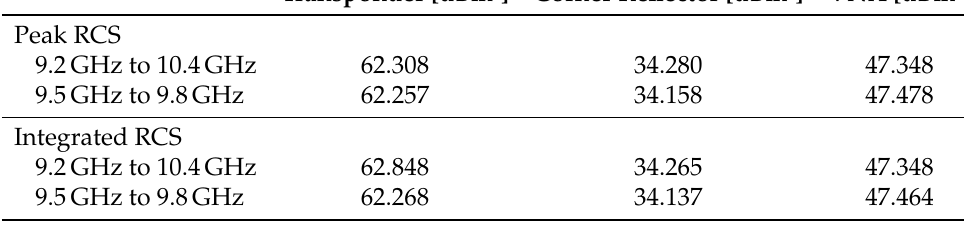
Table 2. Results of the three-transponder measurement campaign. The frequency range 9.2GHz to 10.4GHz equals the full SAR bandwidth available in X-Band while the frequency range of 9.5GHz to 9.8GHz is the operational bandwidth of the SAR satellites TerraSAR-X and TanDEM-X used during